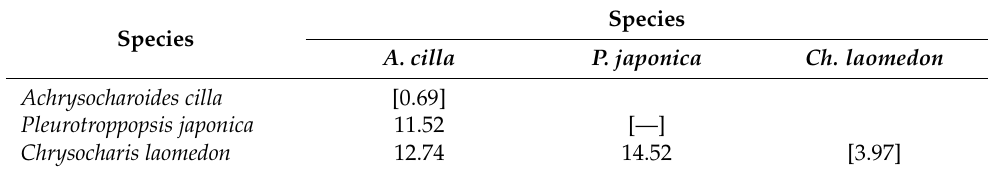
Table 2. Intra- and interspecific divergences in COI mtDNA gene among Entedoninae (Eulophidae) parasitoid species of Phyllonorycter issikii. Minimal pairwise distances are given for each species pair; values in square brackets represent maximal intraspecific distances; [—] no data because a single specimen was sequenced.